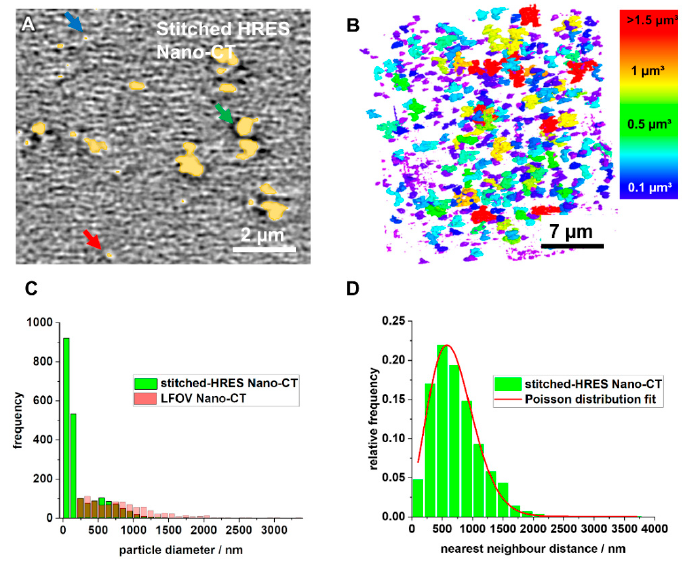
Figure 5. Evaluation of the size and spatial distribution of the Ga-Pd droplets in the LFOV and stitched-HRES nano-CT reconstructions. ( A ) Virtual slice through the reconstructed stitched-HRES nano-CT volume. The yellow areas indicate the segmented Ga-Pd droplets. ( B ) 3D rendering of the segmented Ga-Pd droplets within the stitched-HRES nano-CT volume with the color code indicating their size. ( C ) Particle size distribution (left y-axis, bar chart) of the Ga-Pd droplets (green: stitched-HRES nano-CT, red: LFOV nano-CT). ( D ) Nearest neighbor (NN) distance distribution of all Ga-Pd droplets calculated from the segmented stitched-HRES nano-CT dataset. The droplet distribution is further illustrated in Figure S7.